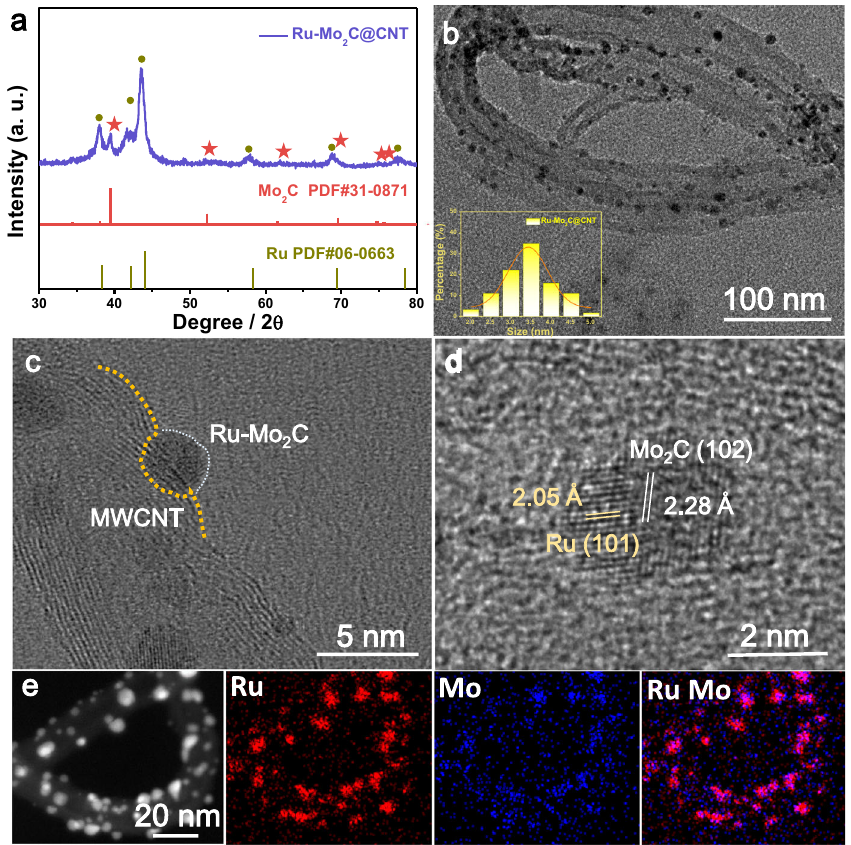
Fig. 1 Physical characterization of Ru-Mo 2 C@CNT catalyst. a The XRD pattern of Ru-Mo 2 C@CNT. b TEM image of Ru-Mo 2 C@CNT, the inset is the size distribution of nanoparticles. c, d HRTEM images of Ru-Mo 2 C@CNT. e HAADF-STEM image and corresponding EDX maps of Ru-Mo 2 C@CNT for Ru, Mo, and Ru + Mo,